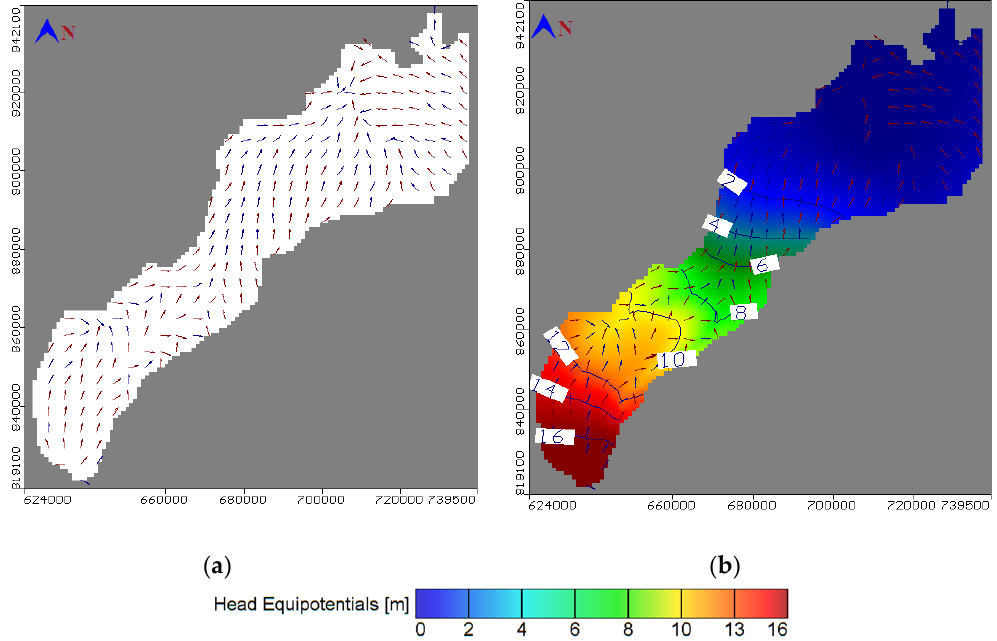
Figure 7. Aerial view of groundwater for ( a ) velocity distribution and ( b ) calculated heads.